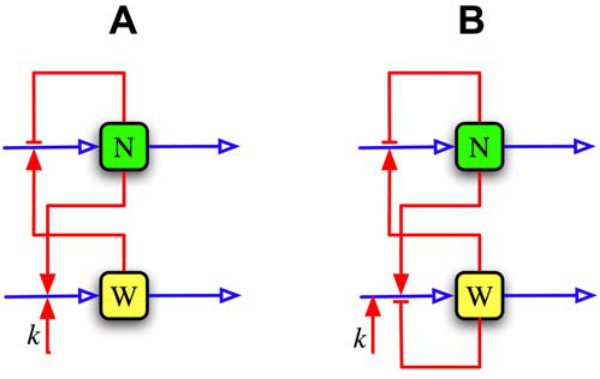
Figure 1. Schematic representations of the regulatory pathway involving genes under the Notch (N) and FGF/Wnt (W) regulatory pathways. The network nodes represent the enzyme levels, the blue arrows pointing into the nodes account for the processes of transcription and translation lumped together, and the blue arrow exiting from the nodes represent enzyme degradation.The regulatory processes are represented by red lines: the lines ending with arrowheads (bars) correspond to up-regulation (down-regulation). Finally, k accounts for the up-regulation of either gene W of the activity of its encoded protein by FGF and/or Wnt.